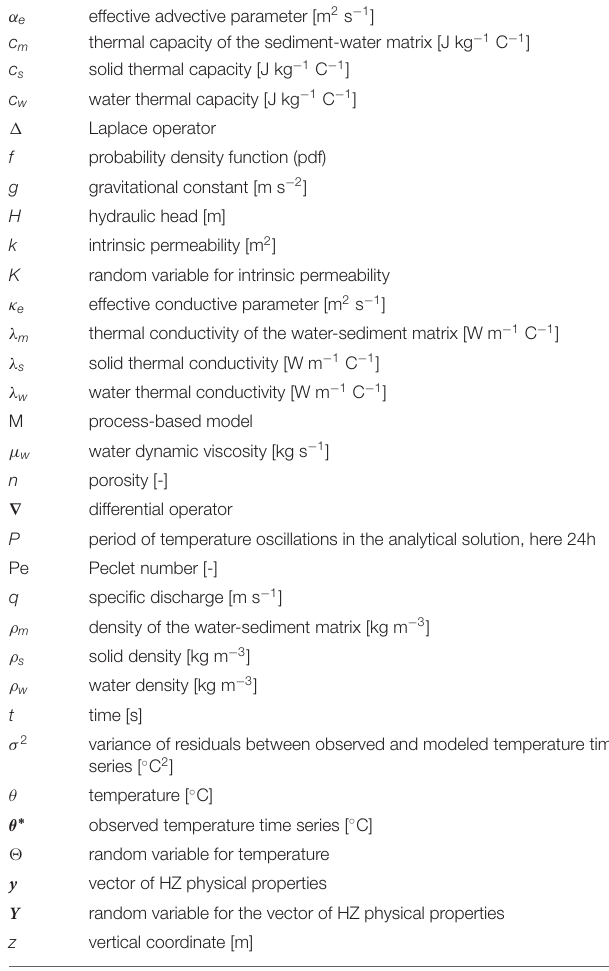
vertical coordinate [m] Bold characters symbolize vectors, the star ( ∗ ) symbolizes